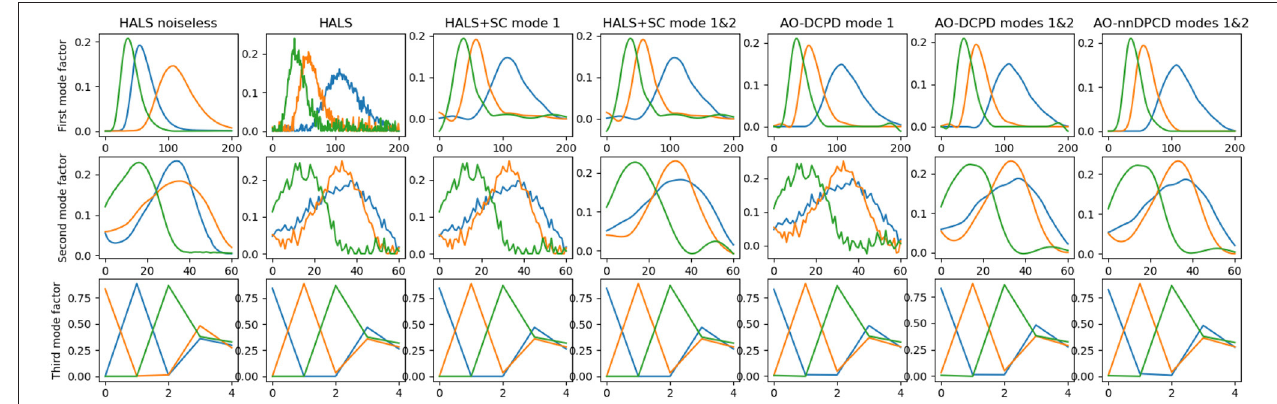
FIGURE 4 | Factors estimated from nonnegative CPD and dictionary-based (non-negative) CPD with smoothness imposed by B-splines on either one (emission, top row ) or two (emission, excitation in middle row ) modes. The (bottom) row shows the third mode factor that relates to relative concentration of the amino-acids in the mixture. The right-most plot shows AO-DLRA when imposing smoothness on two modes and non-negativity on all modes.